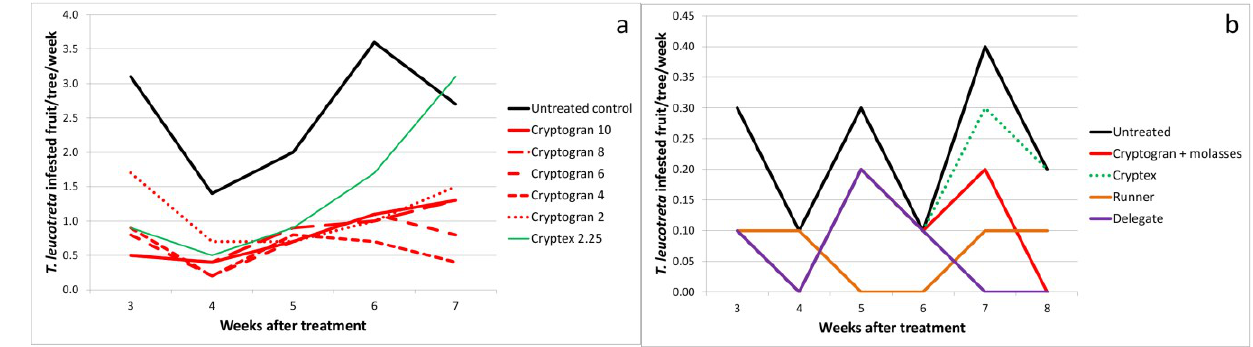
Figure 4. Thaumatotibia leucotreta -infested fruit per tree per week at ( a ) Bernol Farm. The trial was sprayed on 1 December 2004. (Concentrations given in mL/100 L water); ( b ) Far Away Farm. The trial was sprayed on 24 April 2013. (See Table 3 for full treatment application details; see Table 1 for means and standard errors for the full period of